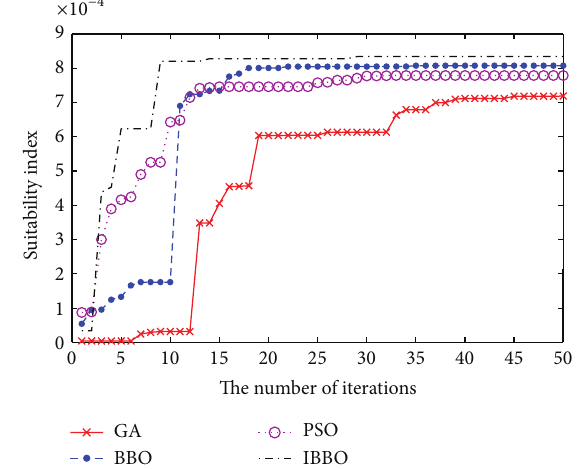
Figure 5: Contrast of suitability index curve of 4 kinds of algorithm optimal